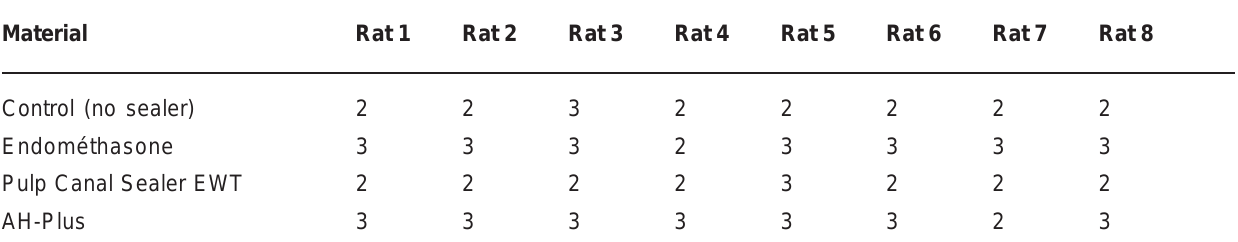
TABLE 1- Distribution of the scores attributed to the materials (Day 3)